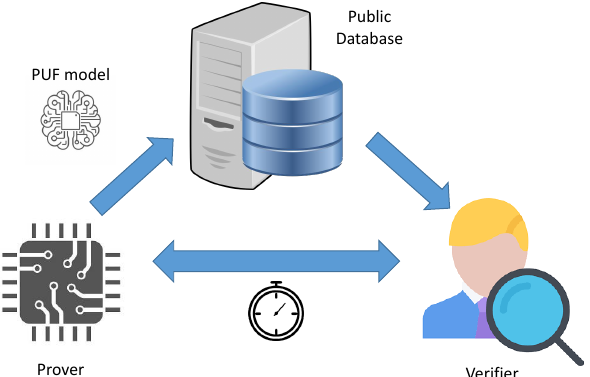
Figure 12. High-Level representation of the time-bound authentication